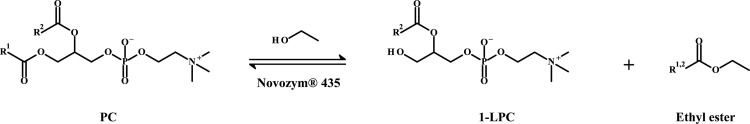
Preparation of 1-LPC via Novozym® 435 (lipase B from Candida antarctica)-catalyzed ethanolysis of PC (R; alkyl).